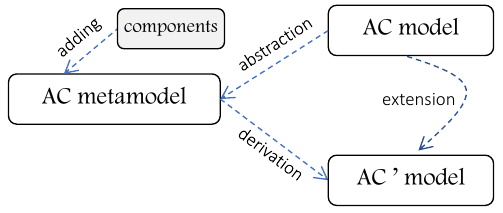
Figure 4. Illustration for model abstraction concept.